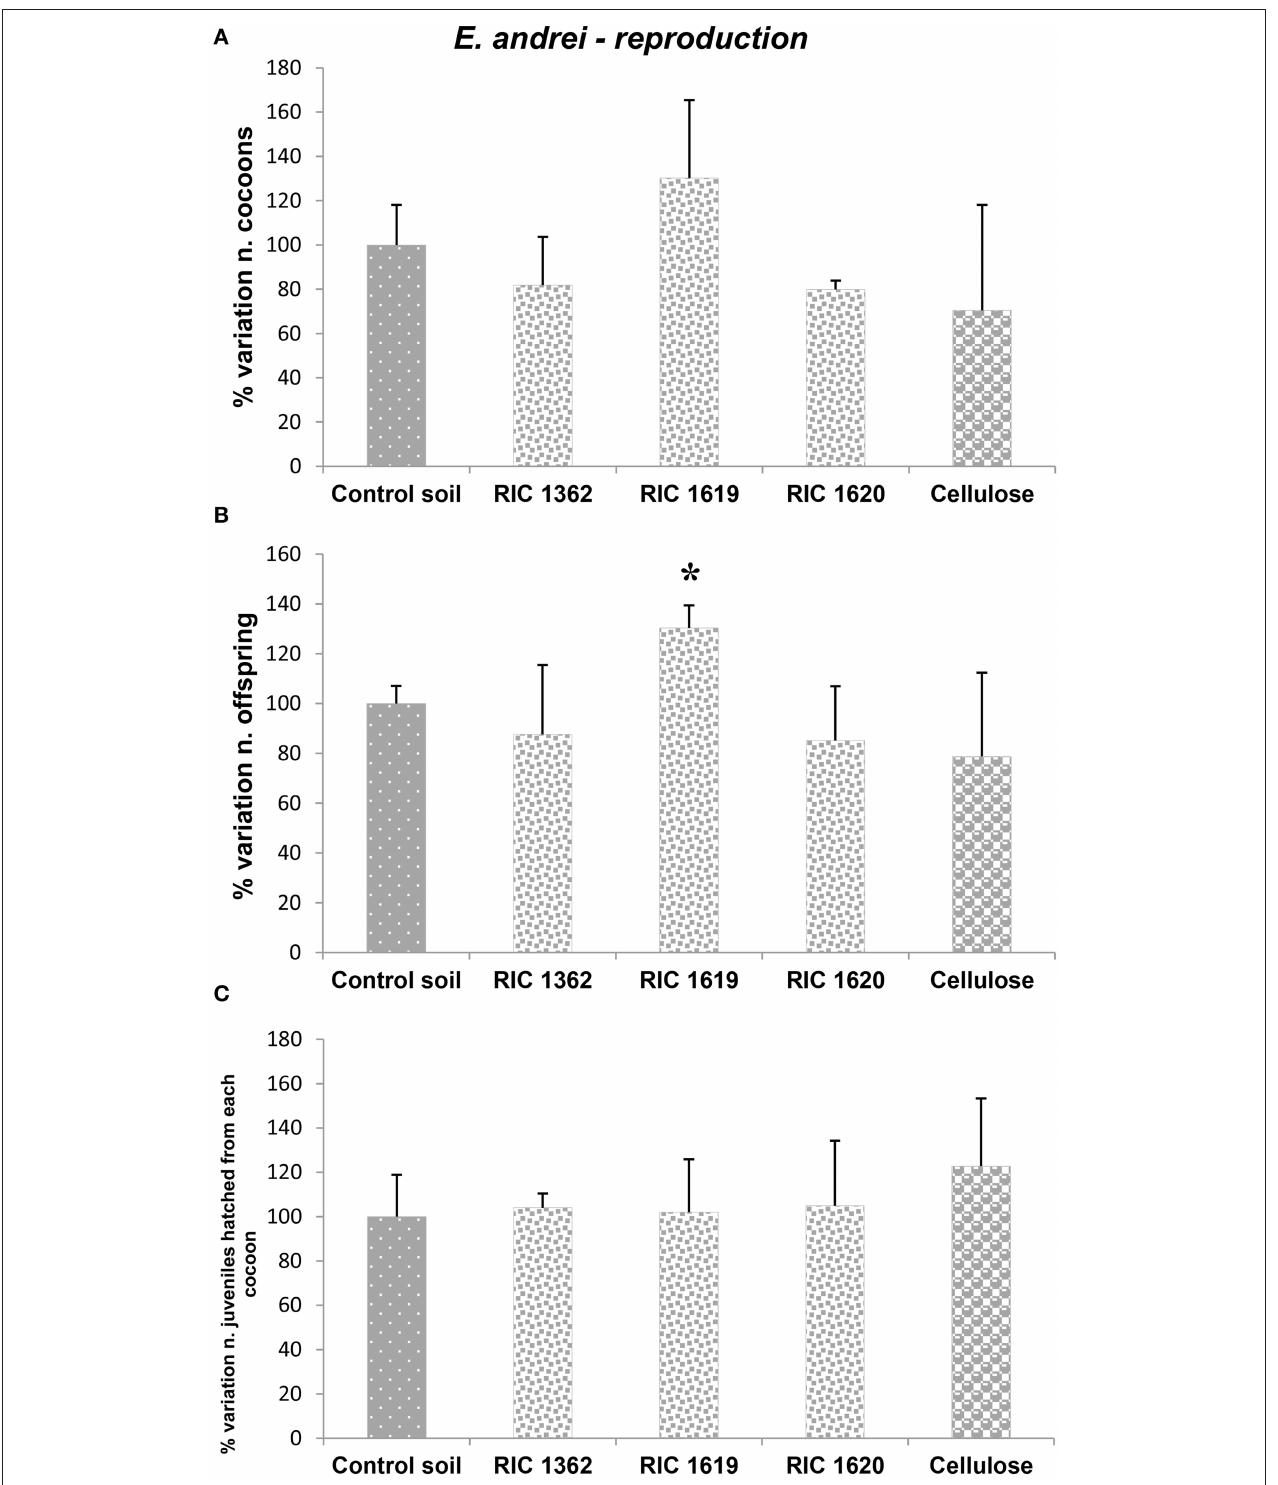
FIGURE 8 | Effects on reproduction of the oligochaete E. andrei exposed to the soil samples: (A) cocoons; (B) offspring; (C) number of juveniles hatched from each cocoon. Data are expressed as % variation with respect to soil control and represent the mean ± SD of at least three replicates. *Indicates statistically significant differences with respect to control values ( p < 0.05 Mann–Whitney U -test). RIC 1362, RIC 1619, RIC 1620, Mater-Bi soils; Cellulose, soil containing cellulose reference material.